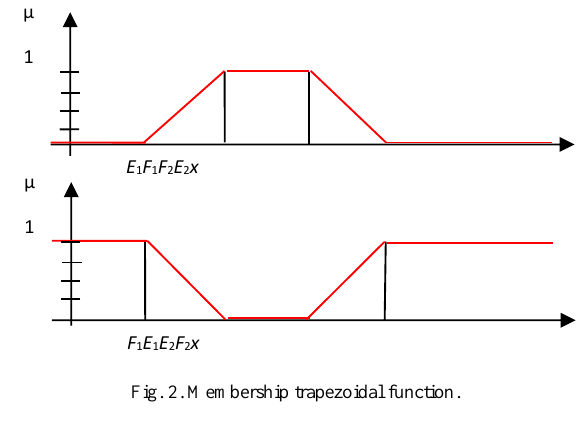
Fig. 2. Membership trapezoidal function.